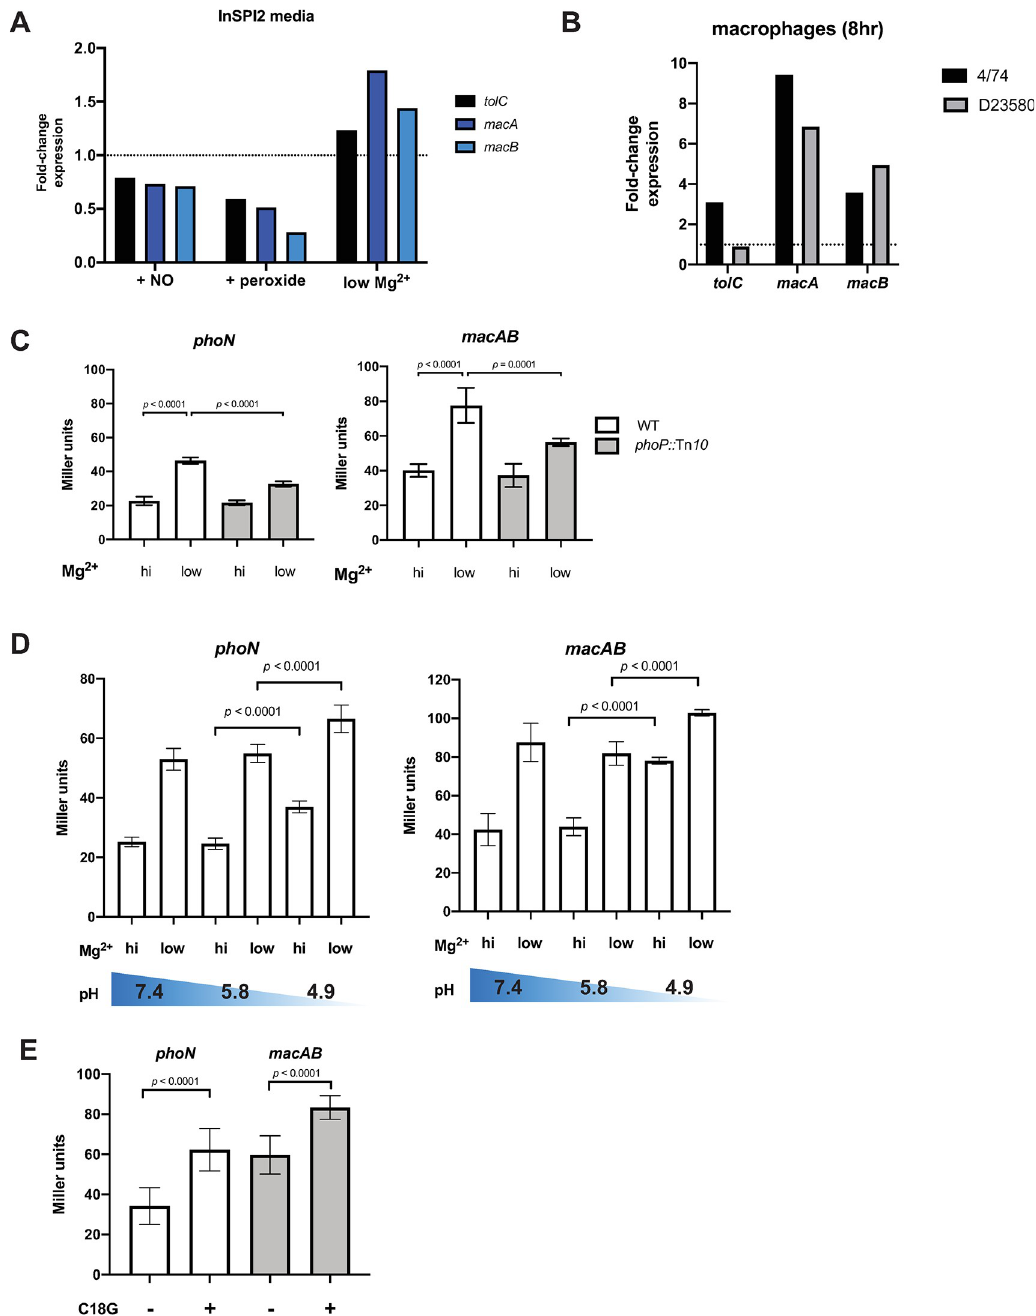
Fig 2. macAB is a PhoP-regulated gene in Salmonella Typhimurium. (A) Gene expression in InSPI2 media in response to environmental stimuli, fold-change relative to InSPI2 medium alone. (B) S . Typhimurium intramacrophage gene expression measured from RAW264.7 macrophages after 8 hours of infection, fold-change relative to expression in LB at early stationary phase. Panels A and B show RNA-seq data extracted from the SalComD23580, SalComMac, and SalComRegulon databases reported previously [18,36,49].(C) ST19 4/74 and 4/74 phoP null mutants ( phoP ::Tn 10 ) with chromosomally integrated lacZY transcriptional fusions for either phoN and macAB were grown to mid-exponential phase in N minimal medium, pH 7.4 and high (10mM) MgCl 2 before transfer to the same or low (10 μ M) MgCl 2 media and growth for 90 minutes. β -galactosidase production was measured by a kinetic Miller assay. (D) At mid-exponential phase, transcriptional fusion strains were shifted from pH 7.4 and 10mM MgCl 2 to media buffered to the indicated pH with high (10mM) or low (10 μ M) MgCl 2 and grown for 90 minutes. (E) Transcriptional fusion strains at mid-exponential phase were exposed to the antimicrobial peptide C18G (5 μ g/mL) in N minimal medium at pH 7.4 with 1mM MgCl 2 and grown for 90 minutes. Data are from three repeat experiments. ANOVA with Tukey post-test (C, D), or t-test (E); bar = mean; error = standard deviation. https://doi.org/10.1371/journal.ppat.1008763.g002 PLOS Pathogens| https://doi.org/10.1371/journal.ppat.1008763 August 24,